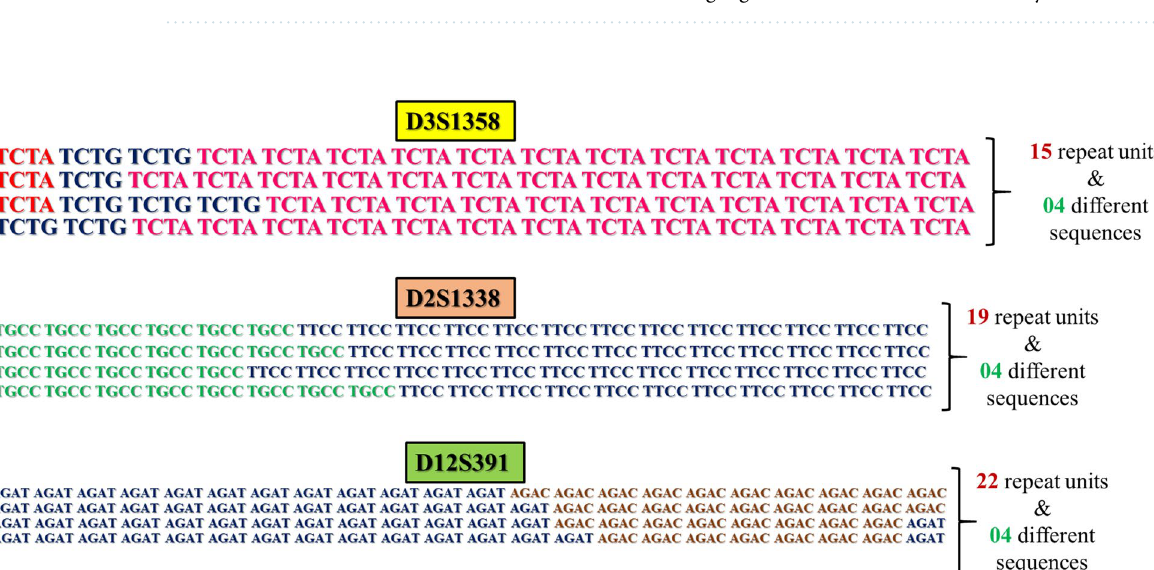
Table 2. Observed SNPs and their characteristics in flanking regions of STRs in the current study.